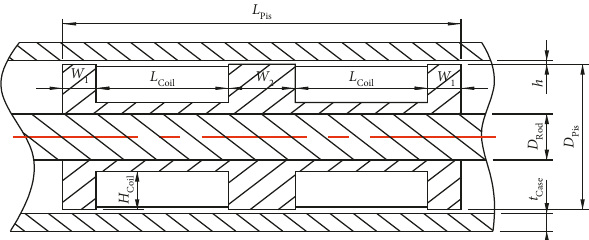
Figure 3: Schematic diagram of design